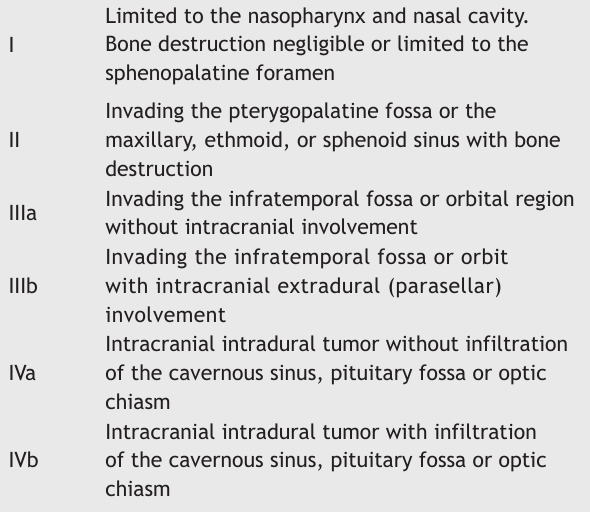
Table 3 Andrews classification of juvenile nasopharyngeal angiofibroma. 8